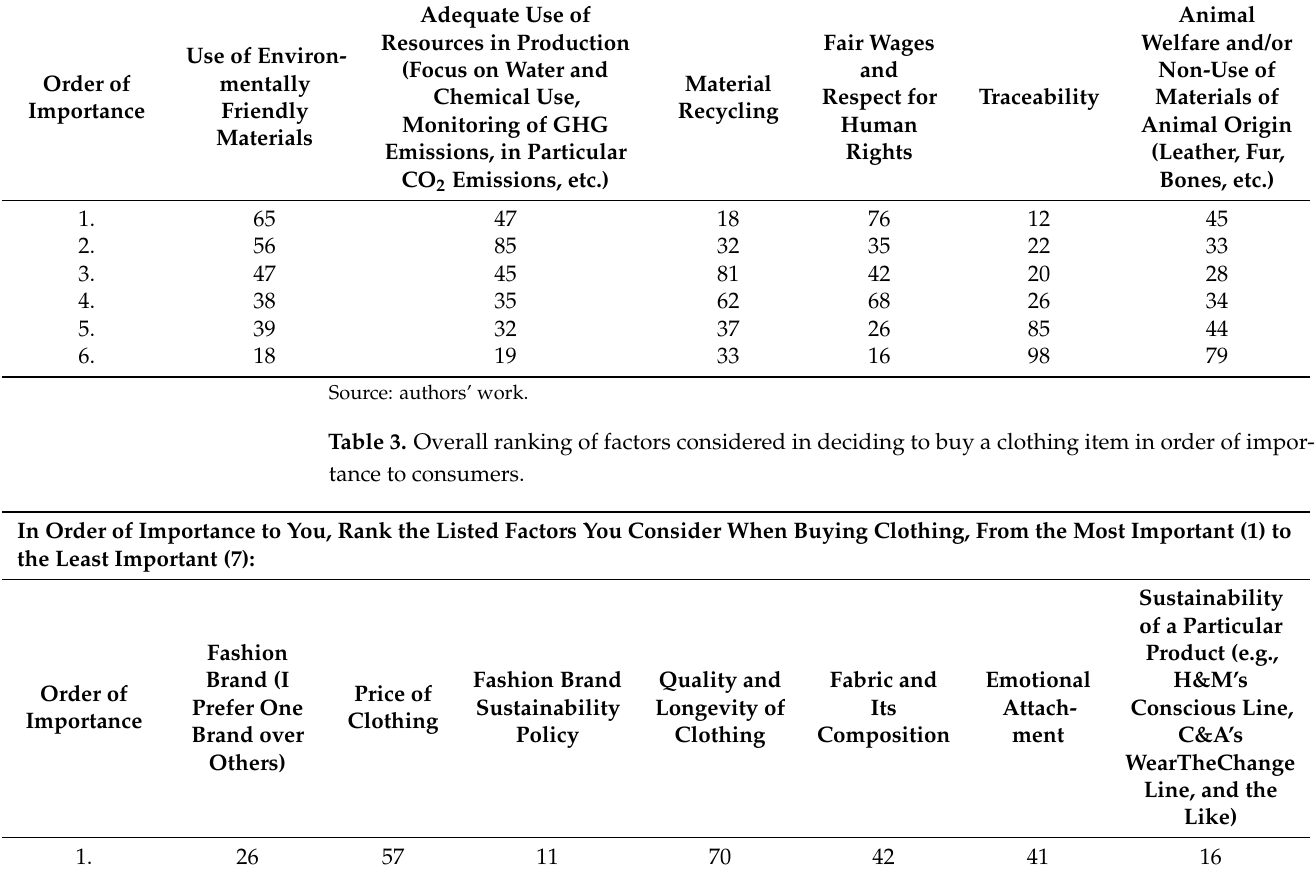
Table 2. Overall ranking of individual factors of sustainable fashion based on importance to the respondents.